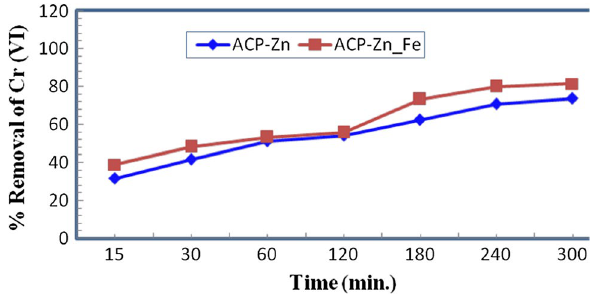
Table 2 Effect of Cr(VI) concentration on ACP-Zn sorption capacity